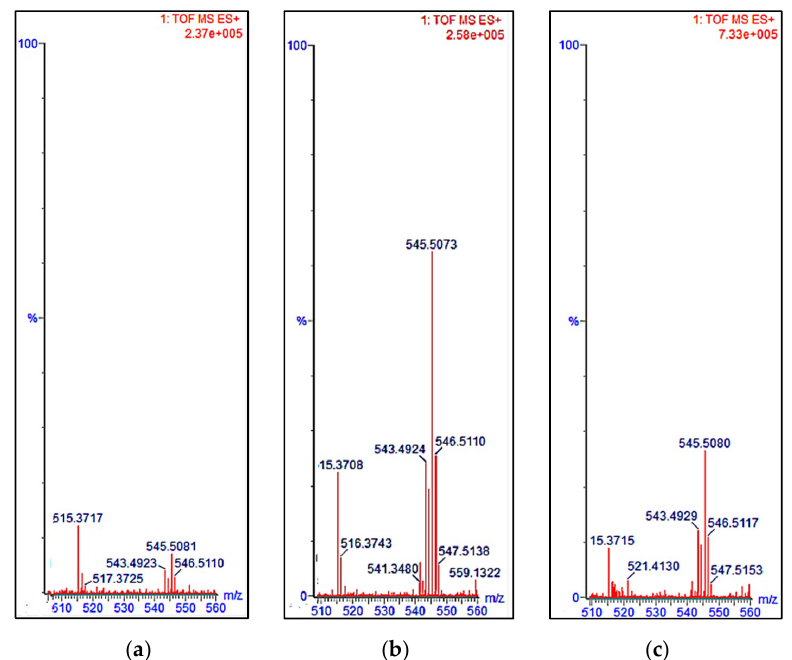
Figure 7. Region of mass spectra showing the molecular mass of phytoene derived from ( a ) ripe tomatoes (545.5081), ( b ) chlorpropham-treated D. salina (545.5073) and ( c ) norflurazon-treated D. salina (545.5080) , in positive ionisation mode [M + H] +